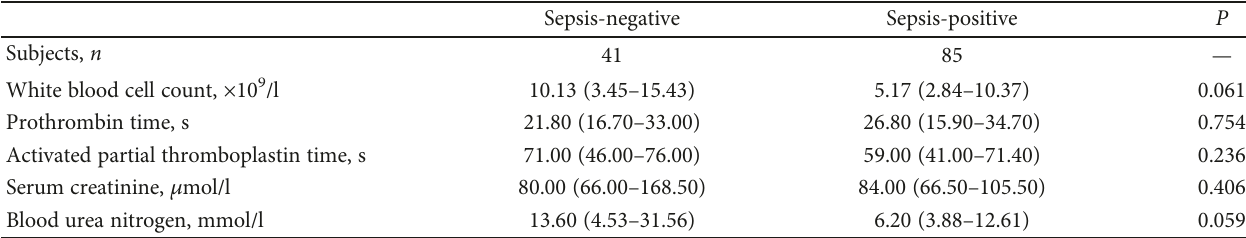
Table 4: Preoperative measurements of patients with or without orthotopic liver transplantation- (OLT-) related sepsis (abnormally distributed data).